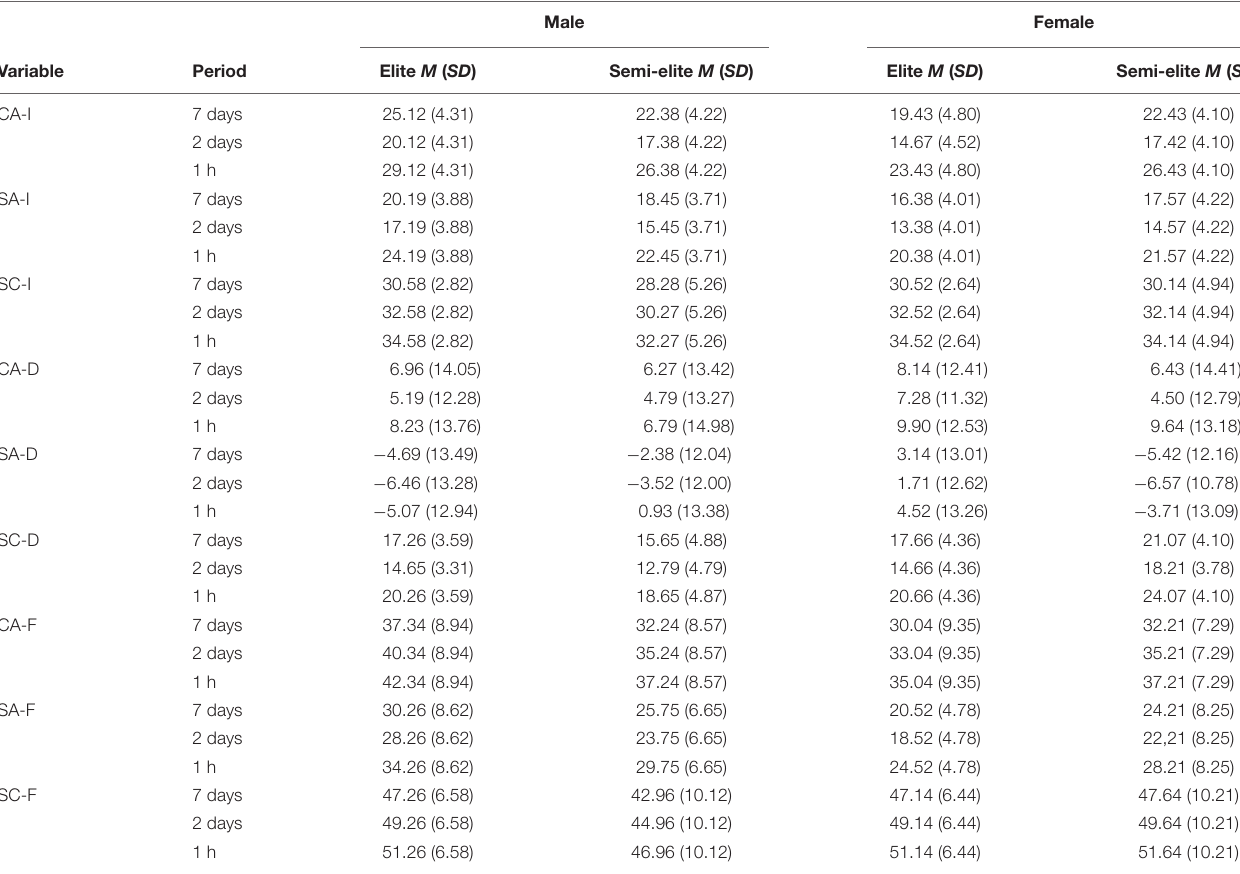
TABLE 1 | Means and standard deviations on overall sub-scales for anxiety and self-confidence across all periods by gender and skill level. Male Female